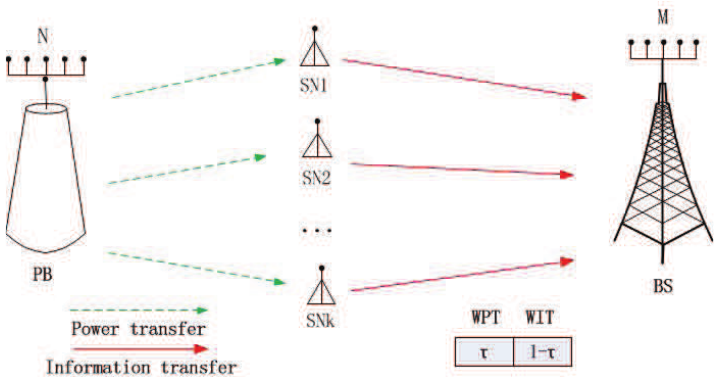
Figure 1. System